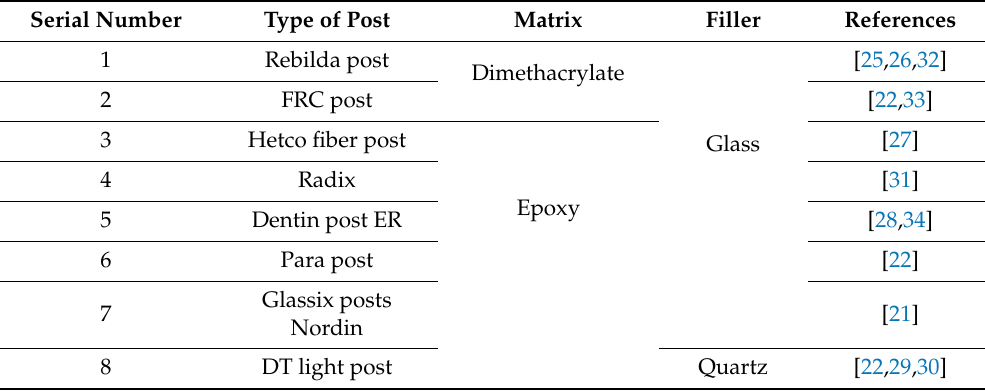
Table 3. Composition of di ff erent FRC post used in the selected invitro